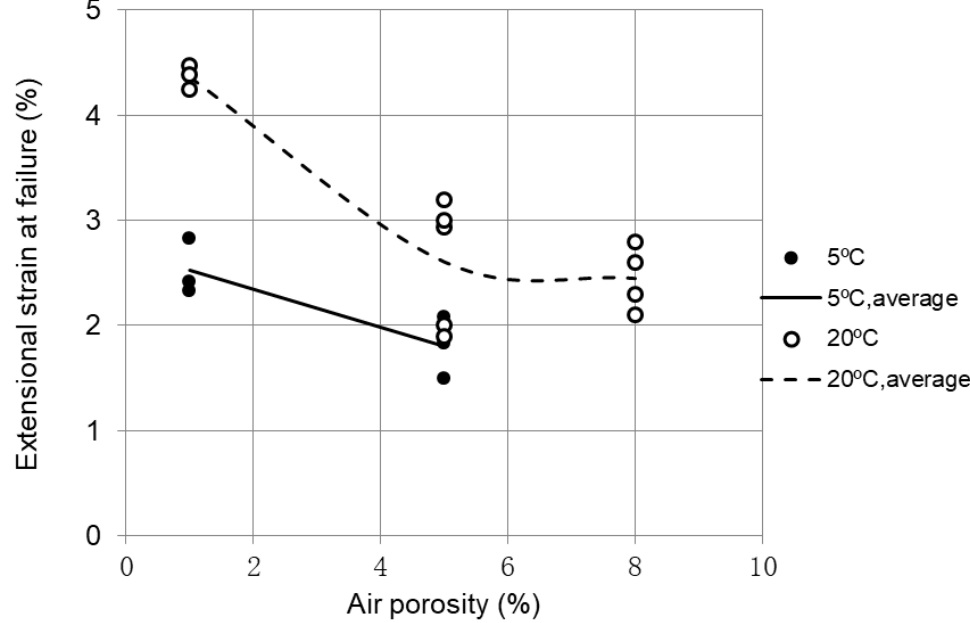
Figure 9. Extensional strain at failure vs. air porosity in middle layer of the specimen by applying water pressure at 5 °C and 20 °C.